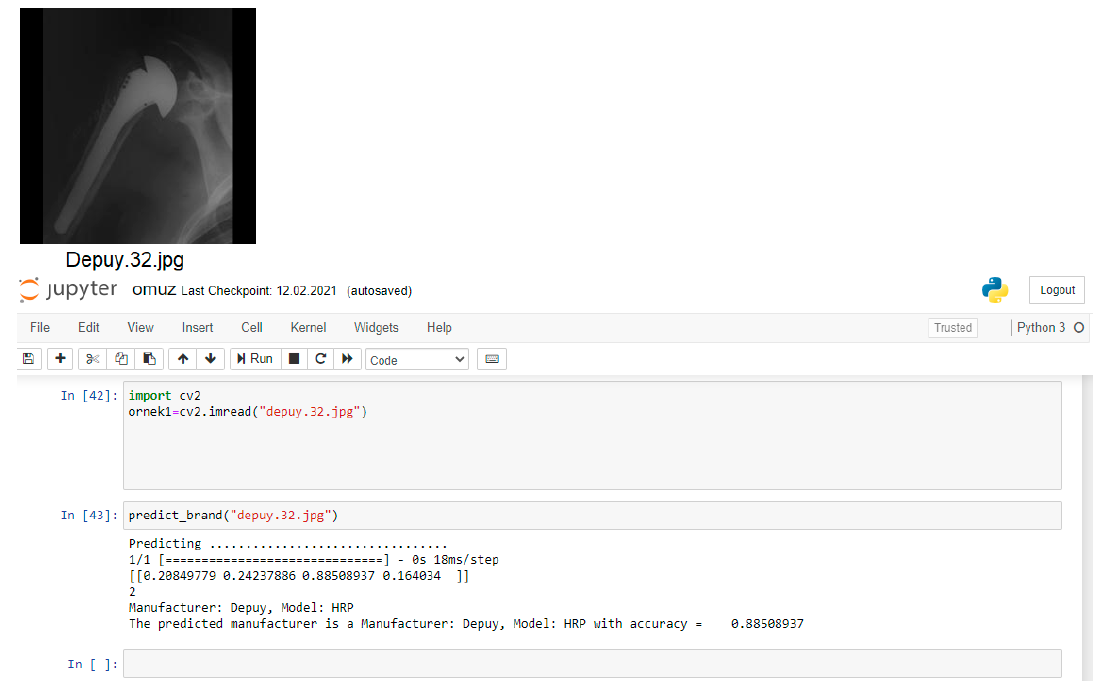
Figure 6. Validation of the applied model.